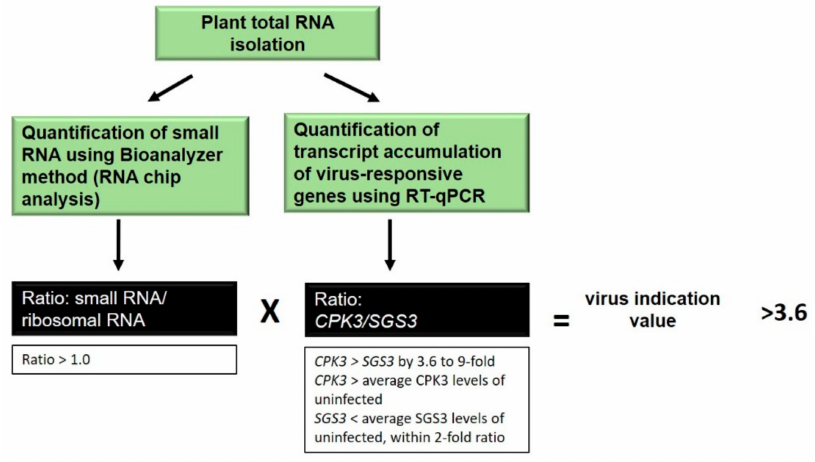
Figure 6. Summary of protocol and example calculation of virus indication